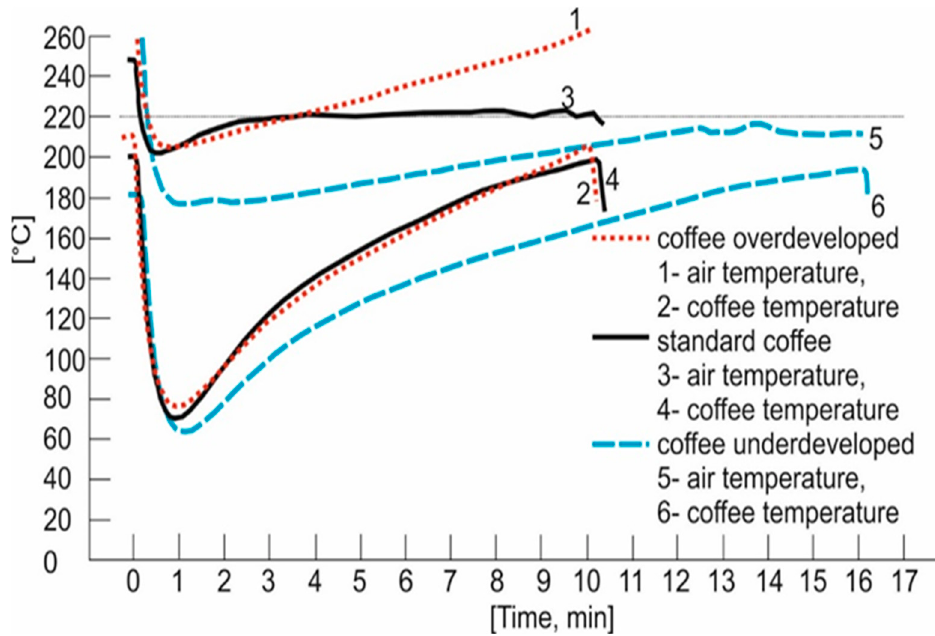
Figure 4. Temperature of coffee beans and air as a function of roasting time.